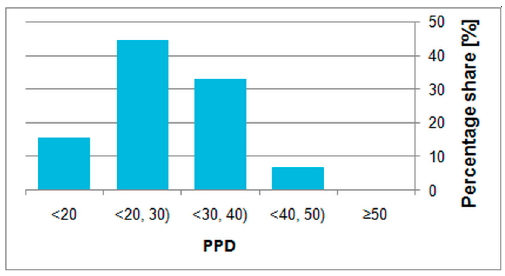
Figure 22. Cumulative share of the PPD index.